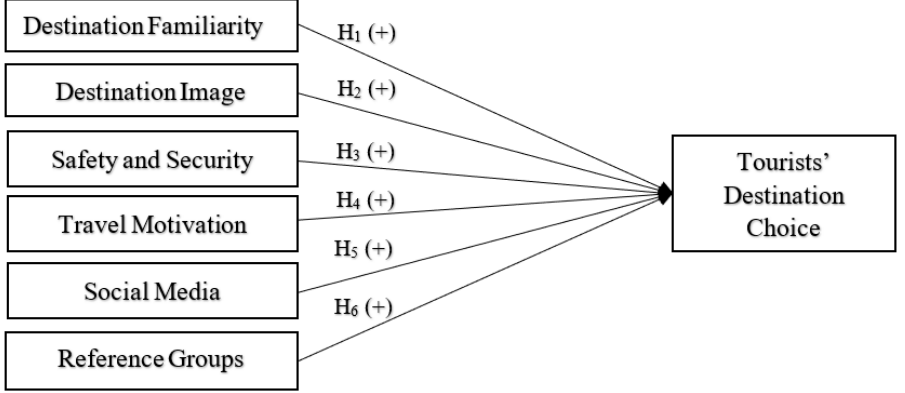
Figure 1. Conceptual